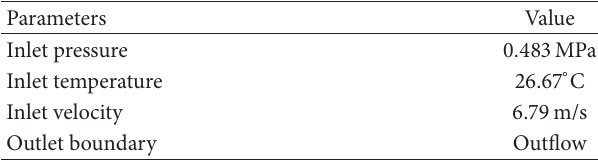
Table 1: Boundary conditions.